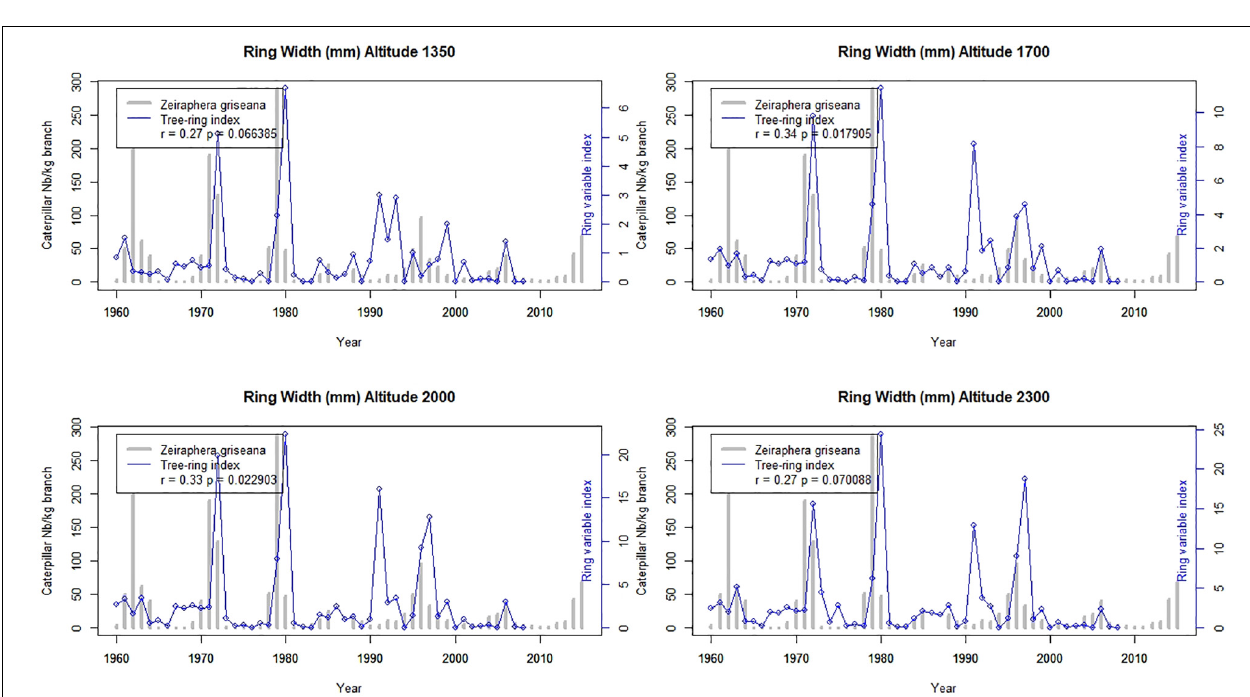
FIGURE 4 | The three ring-variable index showing the best agreement with the LBM outbreaks observed at Les Combes: reconstructed LBM outbreaks at Les Combes (blue lines) and direct observations (gray bars).